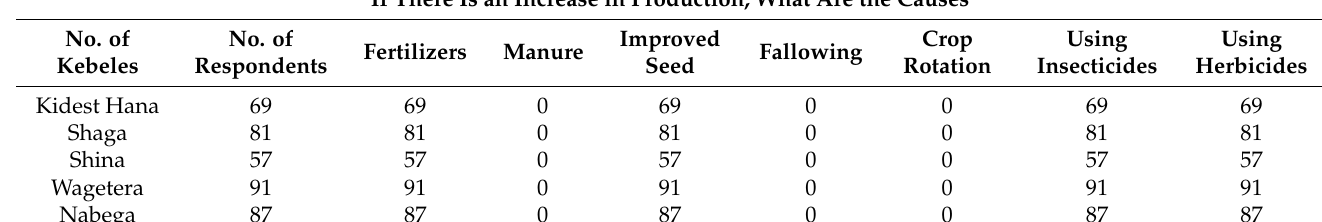
Table 5. Inputs used for the production of crops.